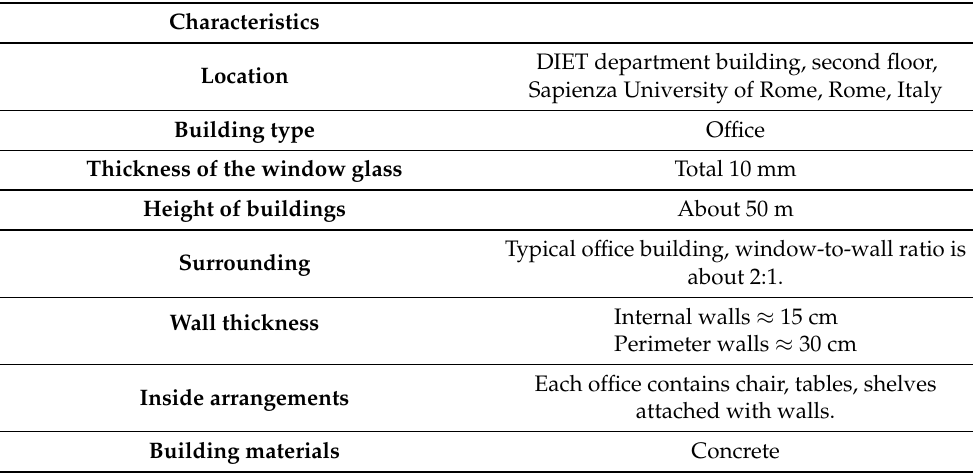
Table 2. Characteristics of the building where measurements were performed.